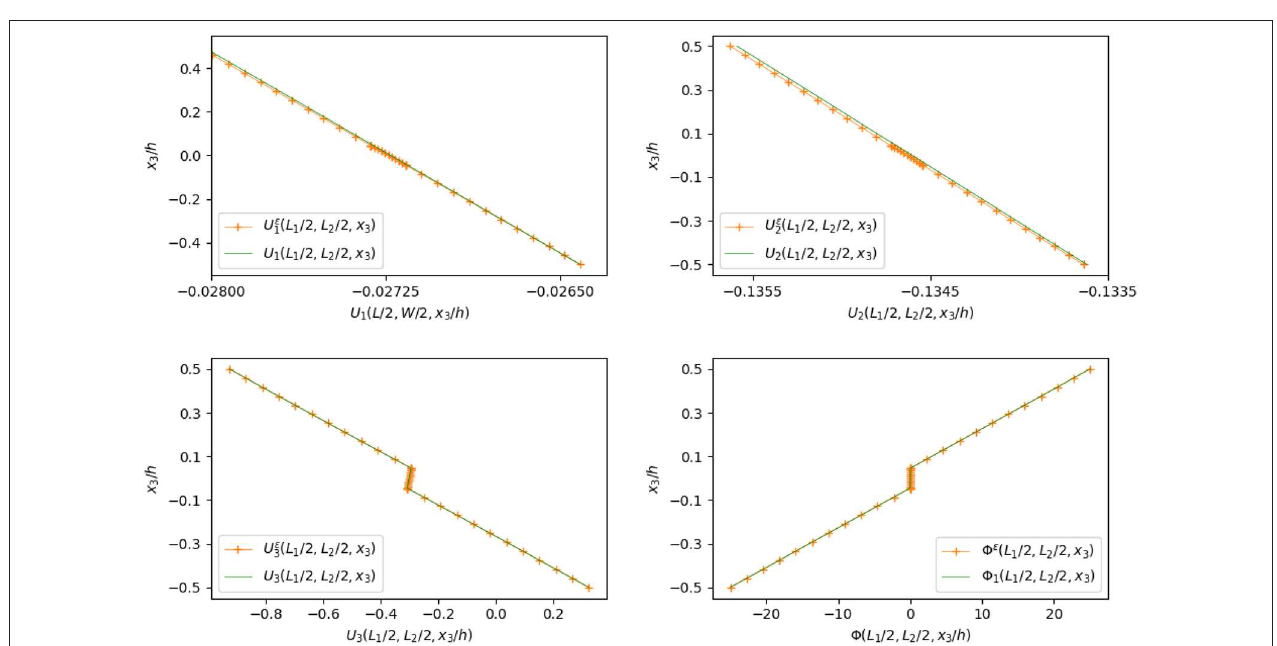
FIGURE 3 | Displacement field and electric potential on a section along the x 3 axis, with ε/ h = 0.1.